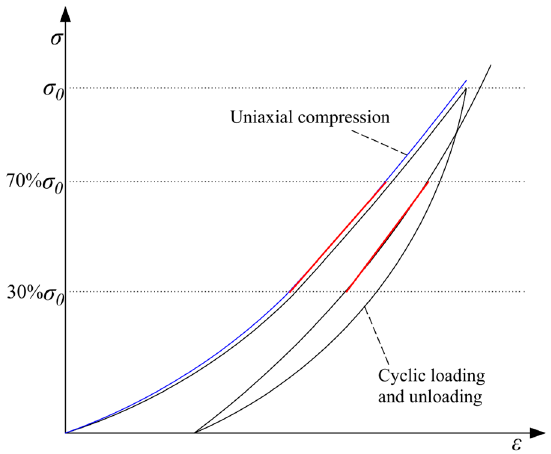
Figure 7. The calculation method of